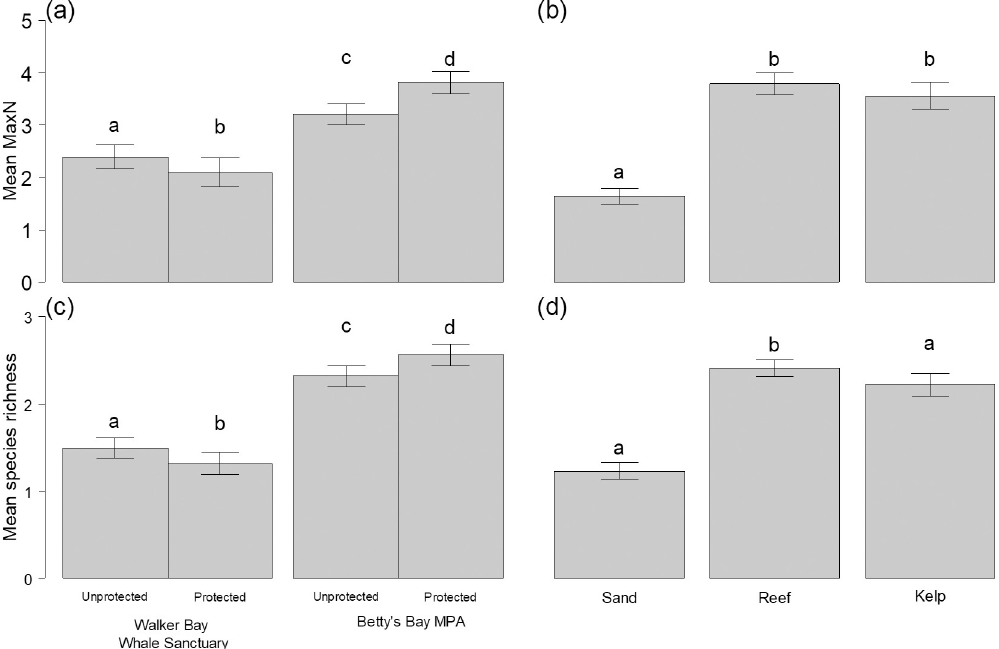
Fig 3. Mean chondrichthyan relative abundance and richness by protection and habitat. (a, b) Mean summed MaxN per BRUV and (c,d) mean species richness per BRUV, compared across: (a, c) protection level in each region and (b, d) habitat type. Bars are +/- SE. Comparisons with the same letter were not significantly